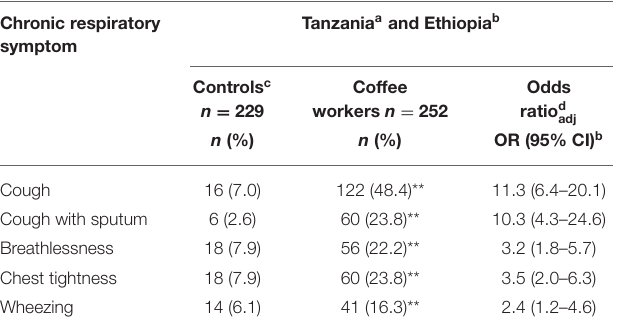
TABLE 3 | Prevalence and odds ratio for chronic respiratory symptoms among male coffee workers and controls from Tanzania and Ethiopia. Chronic respiratory